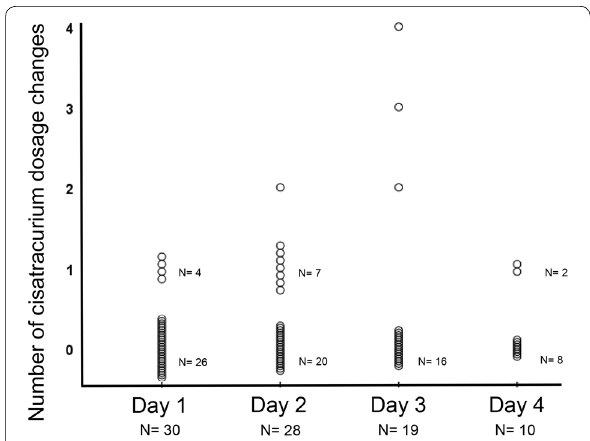
Fig. 4 Cisatracurium dosage changes from day 1 to day 4. Each circle represents a patient. The total number of patients still receiving cisatracurium is given on the abscissa axis